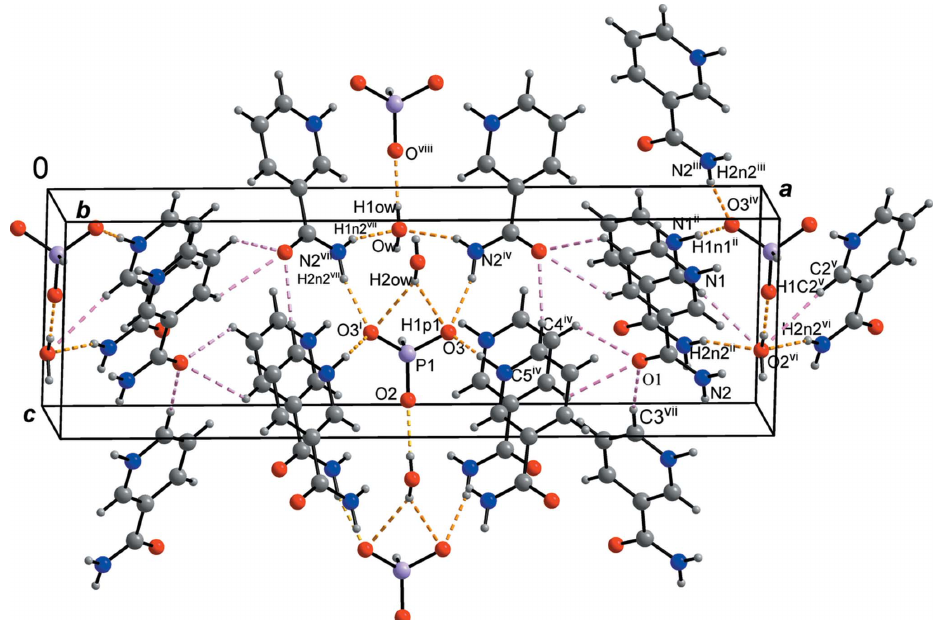
Figure 2 View of the title structure. C, H, N, O and P atoms are represented by gray, small gray, blue, red and violet circles, respectively. [Symmetry codes: (i) (cid:3) x + 1, y , z ; (ii) x , y (cid:3) 1, z ; (iii) x , y (cid:3) 1, z ; (iv) (cid:3) x + 3 z (cid:3) 1.] The hydrogen bonds are shown as yellow dashed lines ( DIAMOND ; Brandenburg & Putz,